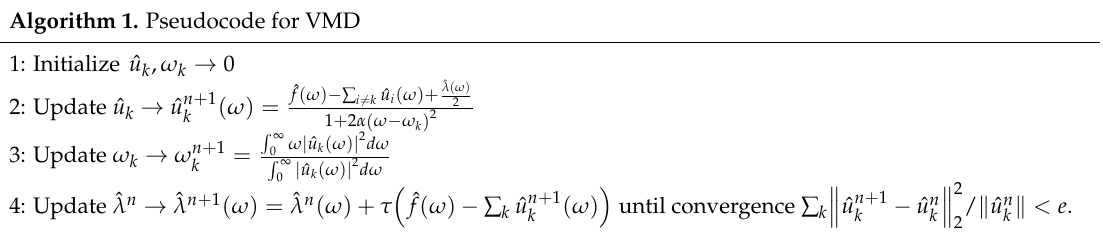
Algorithm 1. Pseudocode for